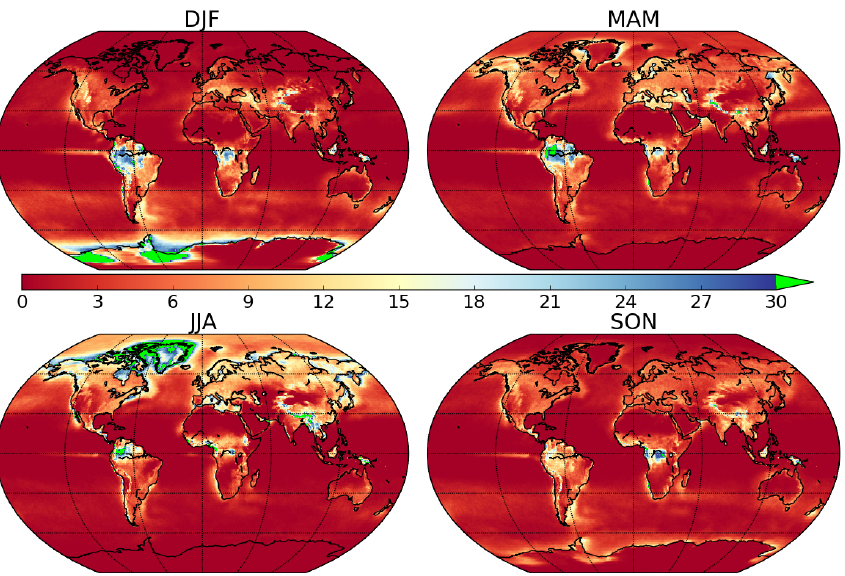
Figure 9. The fractional increase in the seasonal occurrence of dew (%) with a threshold of 0.1mmd − 1 , when the emissivity of the condenser is increased from 0.94 to 0.999, and the albedo from 0.84 to